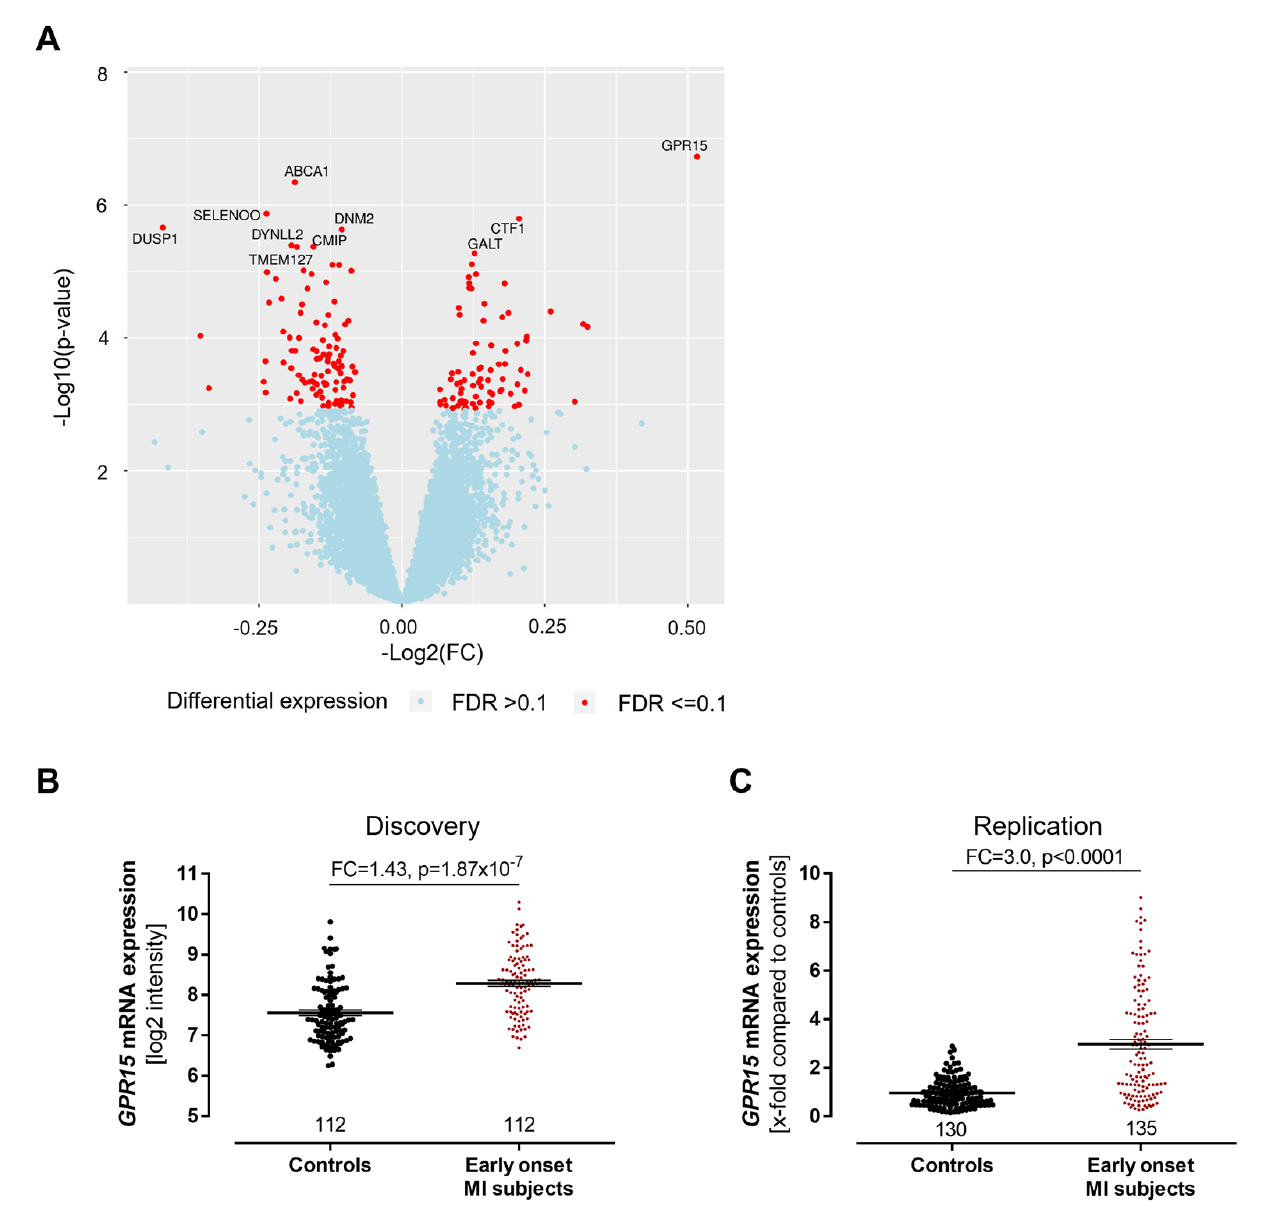
Figure 2. Increased GPR15 expression after myocardial infarction. ( A ) In a transcriptome analysis of peripheral blood mononuclear cells (PBMCs) from 112 early-onset myocardial infarction (MI) patients and 112 age- and gender-matched controls from the GIS discovery cohort, GPR15 , ABCA1 , SELO , CTF1 and DUSP1 were the top differentially expressed genes with GPR15 that displayed the highest fold change and lowest p -value. Linear mixed model adjusted for hypertension, smoking status,